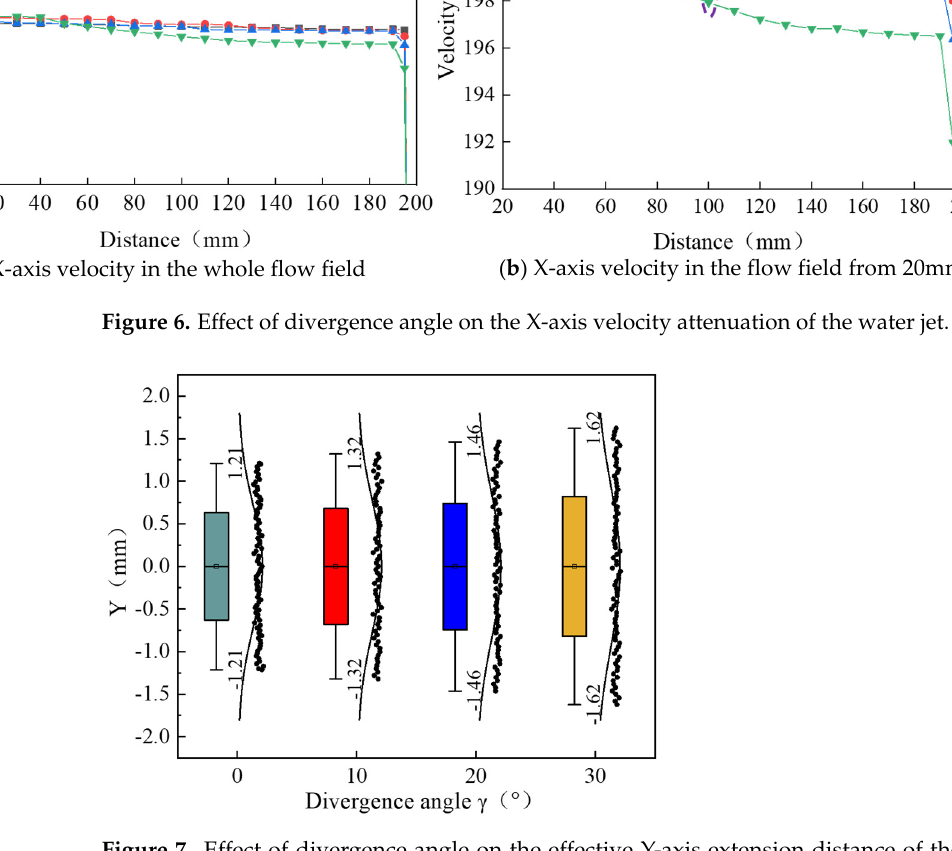
Figure 6. Effect of divergence angle on the X-axis velocity attenuation of the water jet.